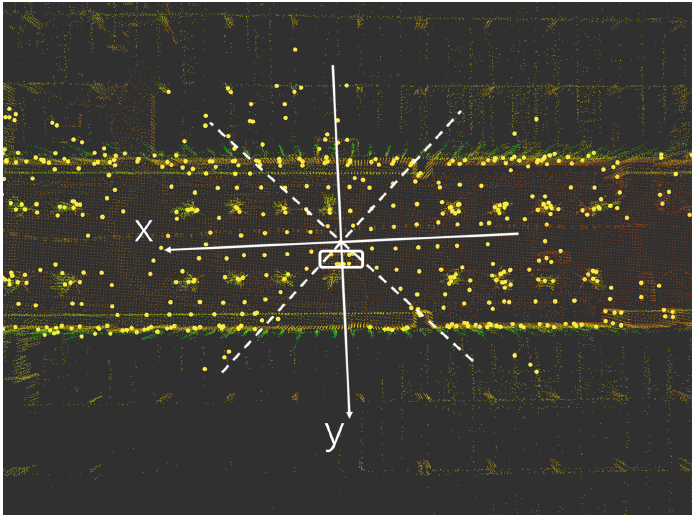
Figure 18. LiDAR point clouds with real obstacles on the